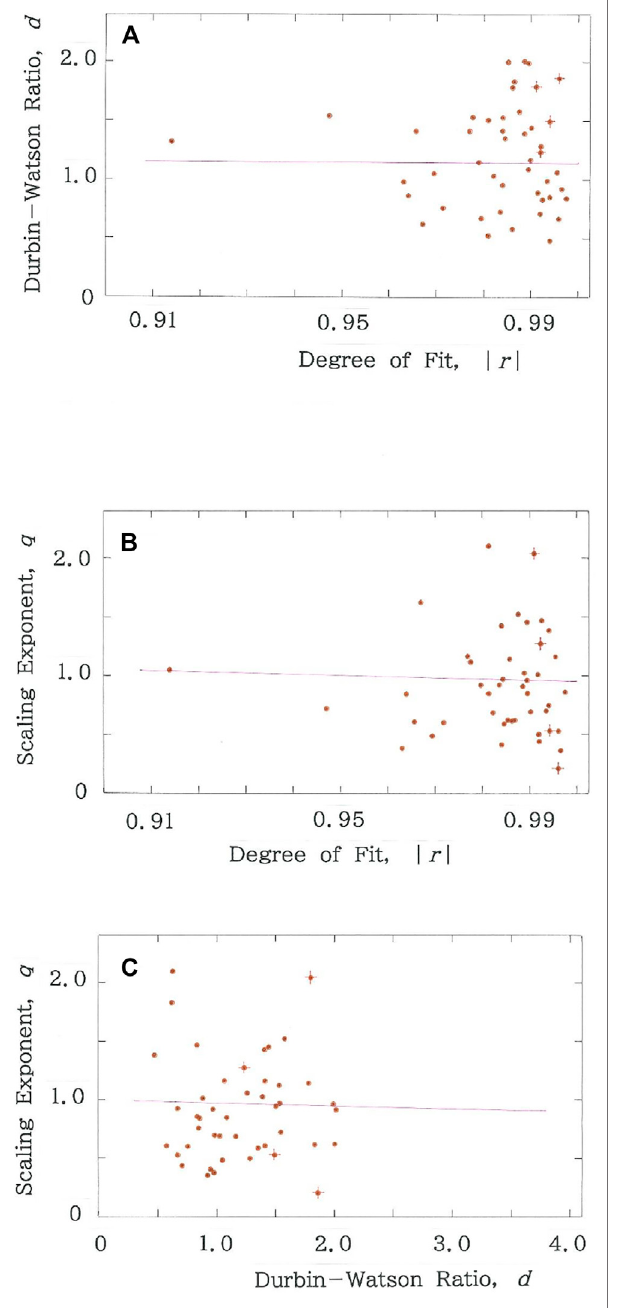
FIGURE 3 | Cross-sectional view of the three-dimensional scattergram of optimal solutions for the entire prefecture in Japan. The purple line in the individual cross section indicates the regression line. The red crosses that are superimposed on the dots highlight thefour prefectures in Tables2 and